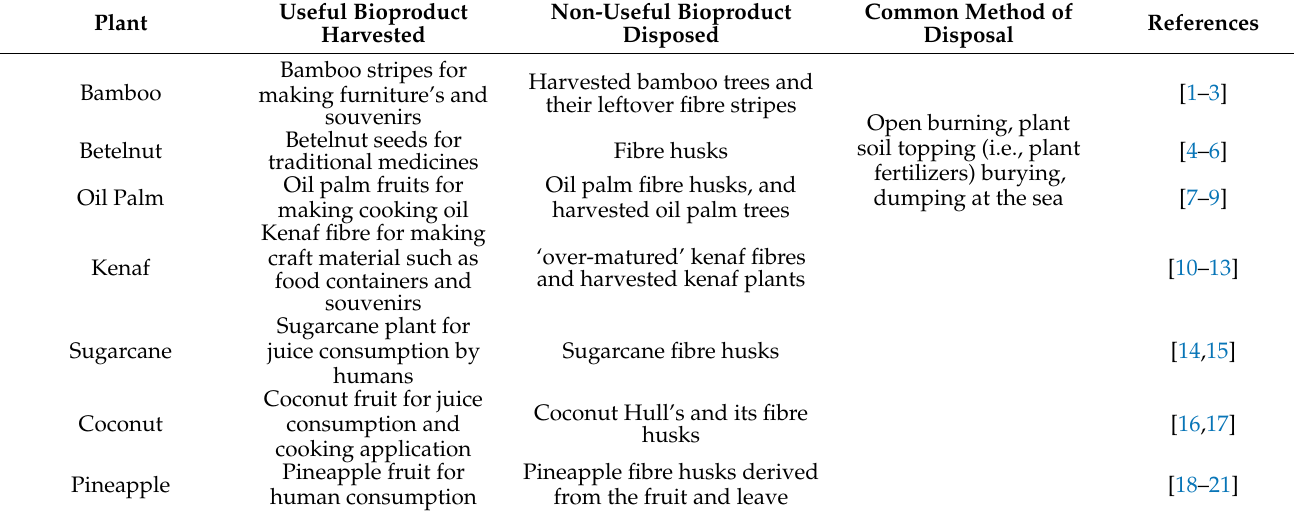
Table 1. Types of agriculture plants illustrating their useful and non-useful bioproducts and common method of disposal. Plant